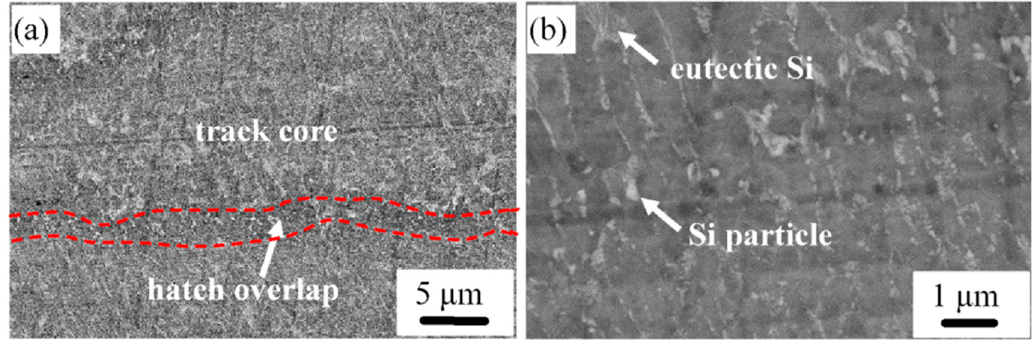
Figure 6. Longitudinal microstructure of the Al–12Si side in the Al–(12-20)Si bi-material ( a ) low magnification and ( b ) high magnification.